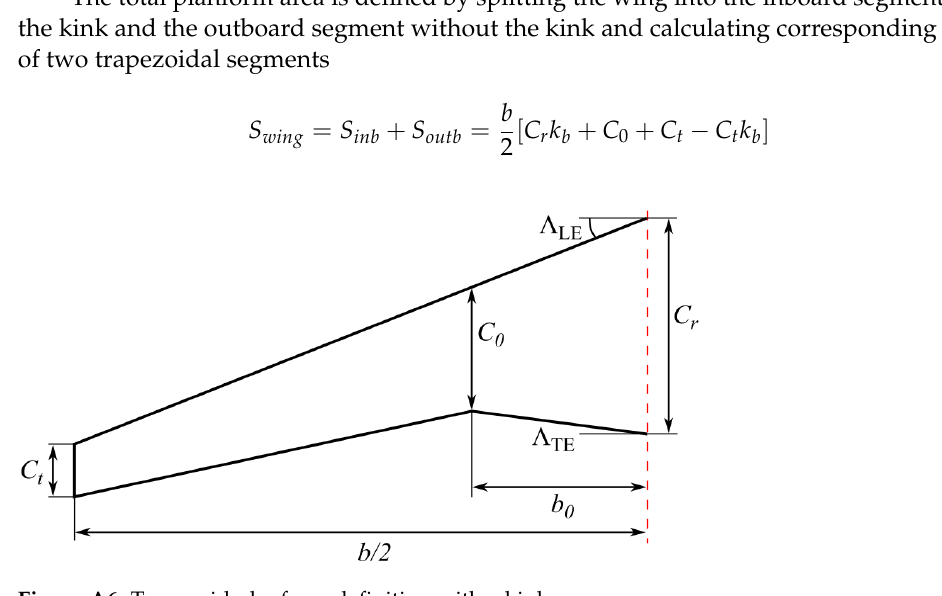
Figure A6. Trapezoid planform definition with a